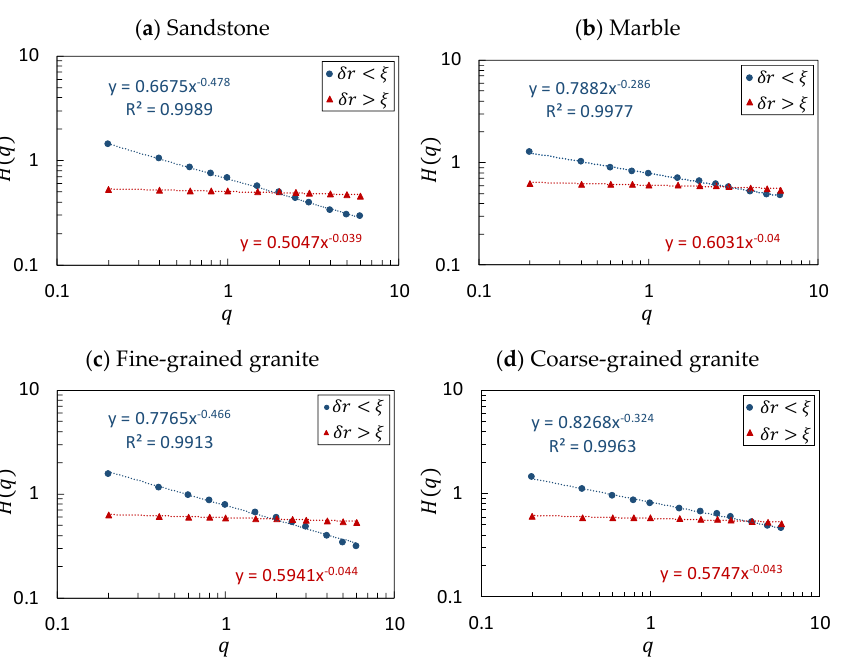
Figure 4. Multiscaling spectra of the rock fractured surfaces: sandstone ( a ), marble ( b ) fine-grained granite ( c ), and coarse grained granite ( d ). The spectra are computed both below (blue curve) and above (red curve) ξ . Both regimes are predicted with power laws; the best fit lines and their equations are represented with the same colour. Intermittency of multifractal regimes ( δ r < ξ ) are showing perfect power laws with R 2 ≈ 1 and some exponents between 0.25 and 0.5. Monofractal regimes ( δ r > ξ ), however, show insignificant intermittency whose exponents are less than 0.05. Coefficients of presented equations represent H ( 1 ) = ζ 1 /1, which is sometimes considered as a Hurst exponent. Its values range from 0.5 to 0.6 for monofractal regimes, and from 0.65 to 0.85 for multifractal